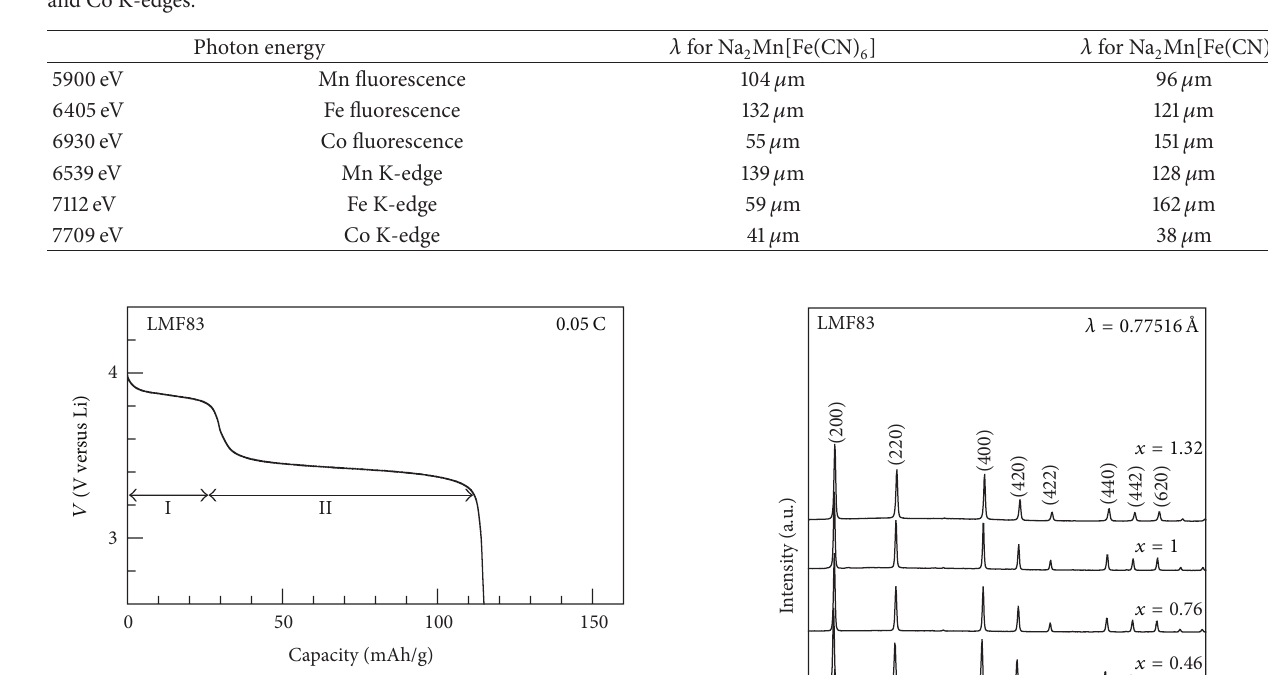
Table 3: Penetration depths (𝜆) for ideal Na and Co K-edges.